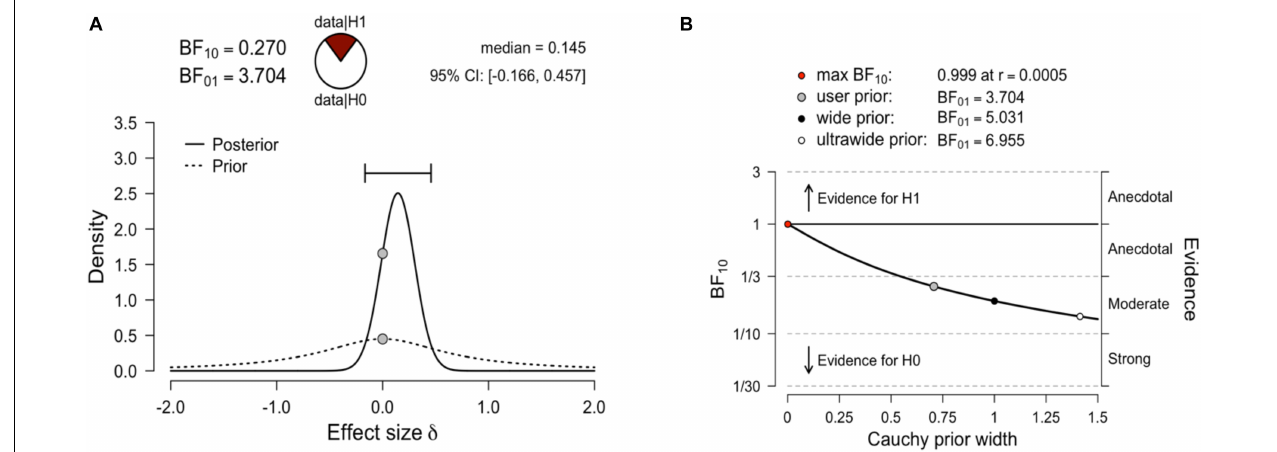
FIGURE 2 | (A) Bayesian independent samples t- test for the effect size δ . The dashed line illustrates the prior distribution (default Cauchy prior centered on zero, r = 0.707), the solid line shows the posterior distribution. The two gray dots indicate the prior and posterior density at the test value. The probability wheel on top visualizes the evidence that the data provide for the null hypothesis (H0: effect sizes are equal) and the alternative hypothesis (auburn, H1: effect sizes are different). The median and the 95% central credible interval of the posterior distribution are shown in the top right corner. (B) The Bayes factor robustness plot. The plot indicates the Bayes factor BF01 (in favor of the null hypothesis) for the default prior ( r = 0.707), a wide prior ( r = 1), and an ultrawide prior ( r = 1.414). All priors suggest moderate evidence for the null hypothesis, which is relatively stable across a wide range of prior distributions. Plots taken from